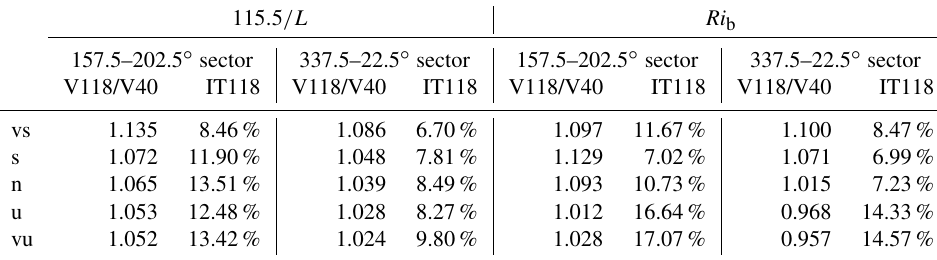
Table 6. Wind shear and turbulence intensity in each of the stability classes. On the left is based on z/L , and on the right is based on Ri b